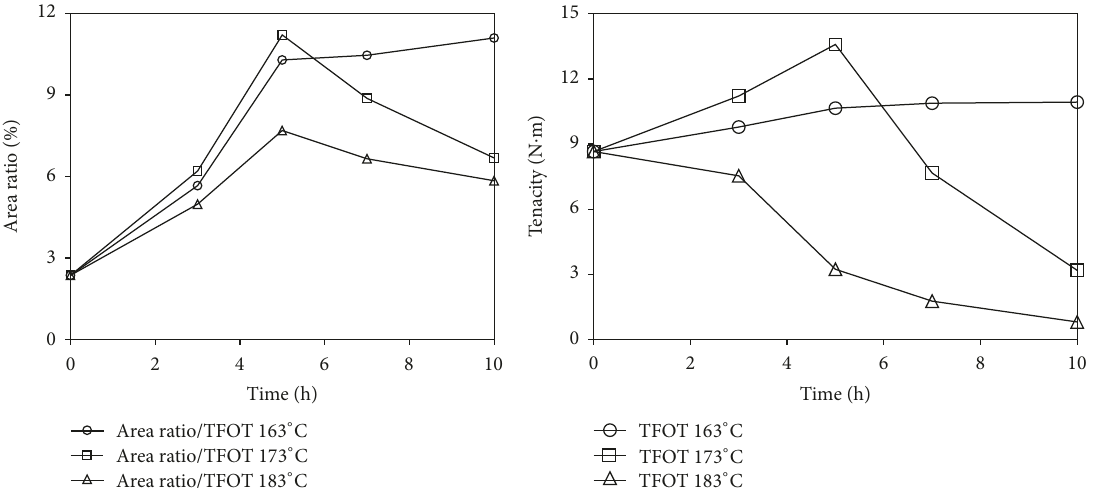
Figure 9: Correlation of SBS particle area ratio and tenacity with aging time.